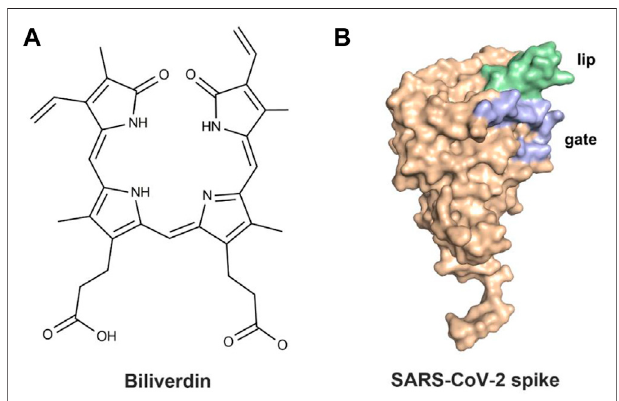
Frontiers in Molecular Biosciences |